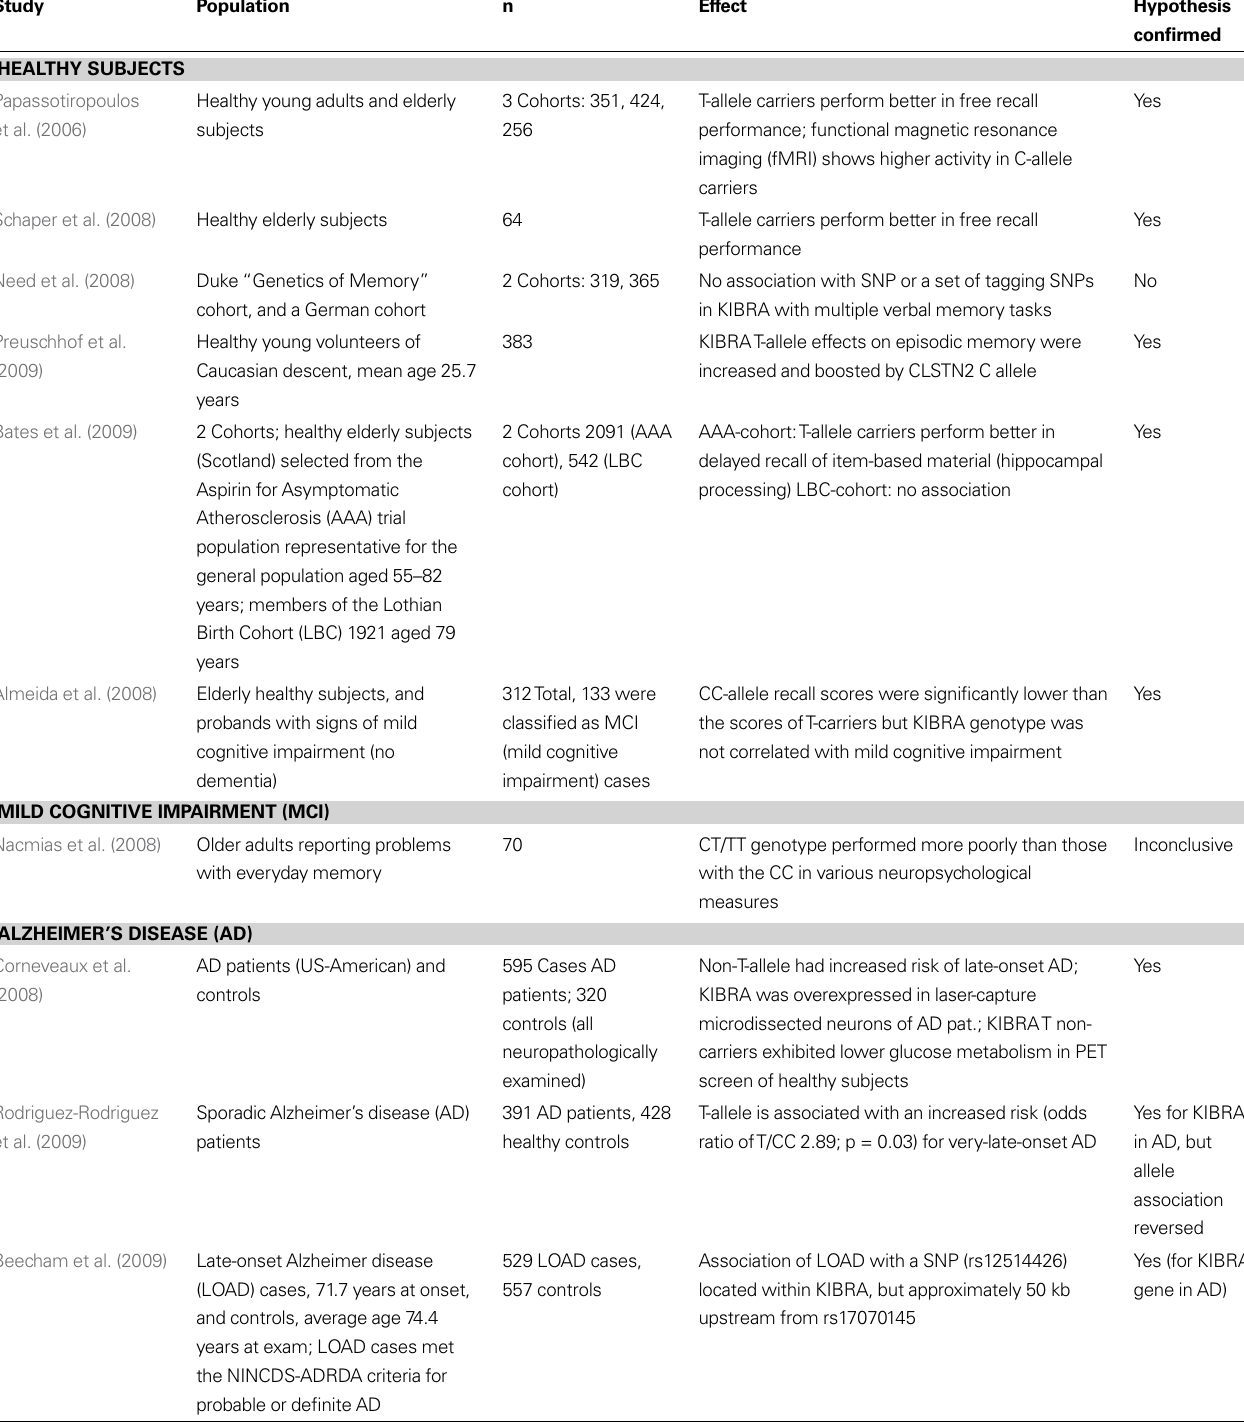
Table 1 | Summary of the genetic association data available on the KIBRA polymorphism and memory and Alzheimer’s disease. Twelve studies that examine the KIBRA polymorphism in different populations are listed that were published before December 2009. Summarized are the citation and publication year, the population(s) examined, the study size, the effect(s) observed, and fi nally whether the study confi rmed the association of the rs17070145 SNP with memory